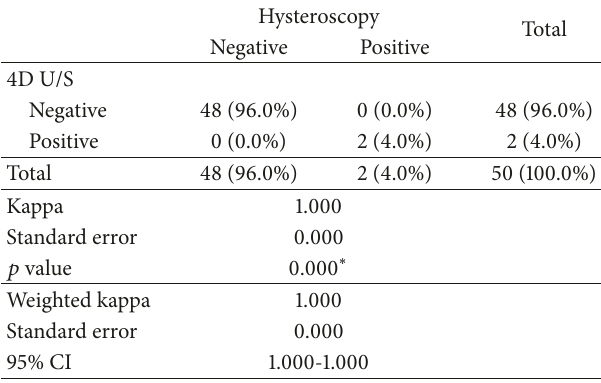
Table 5: Hypoplastic